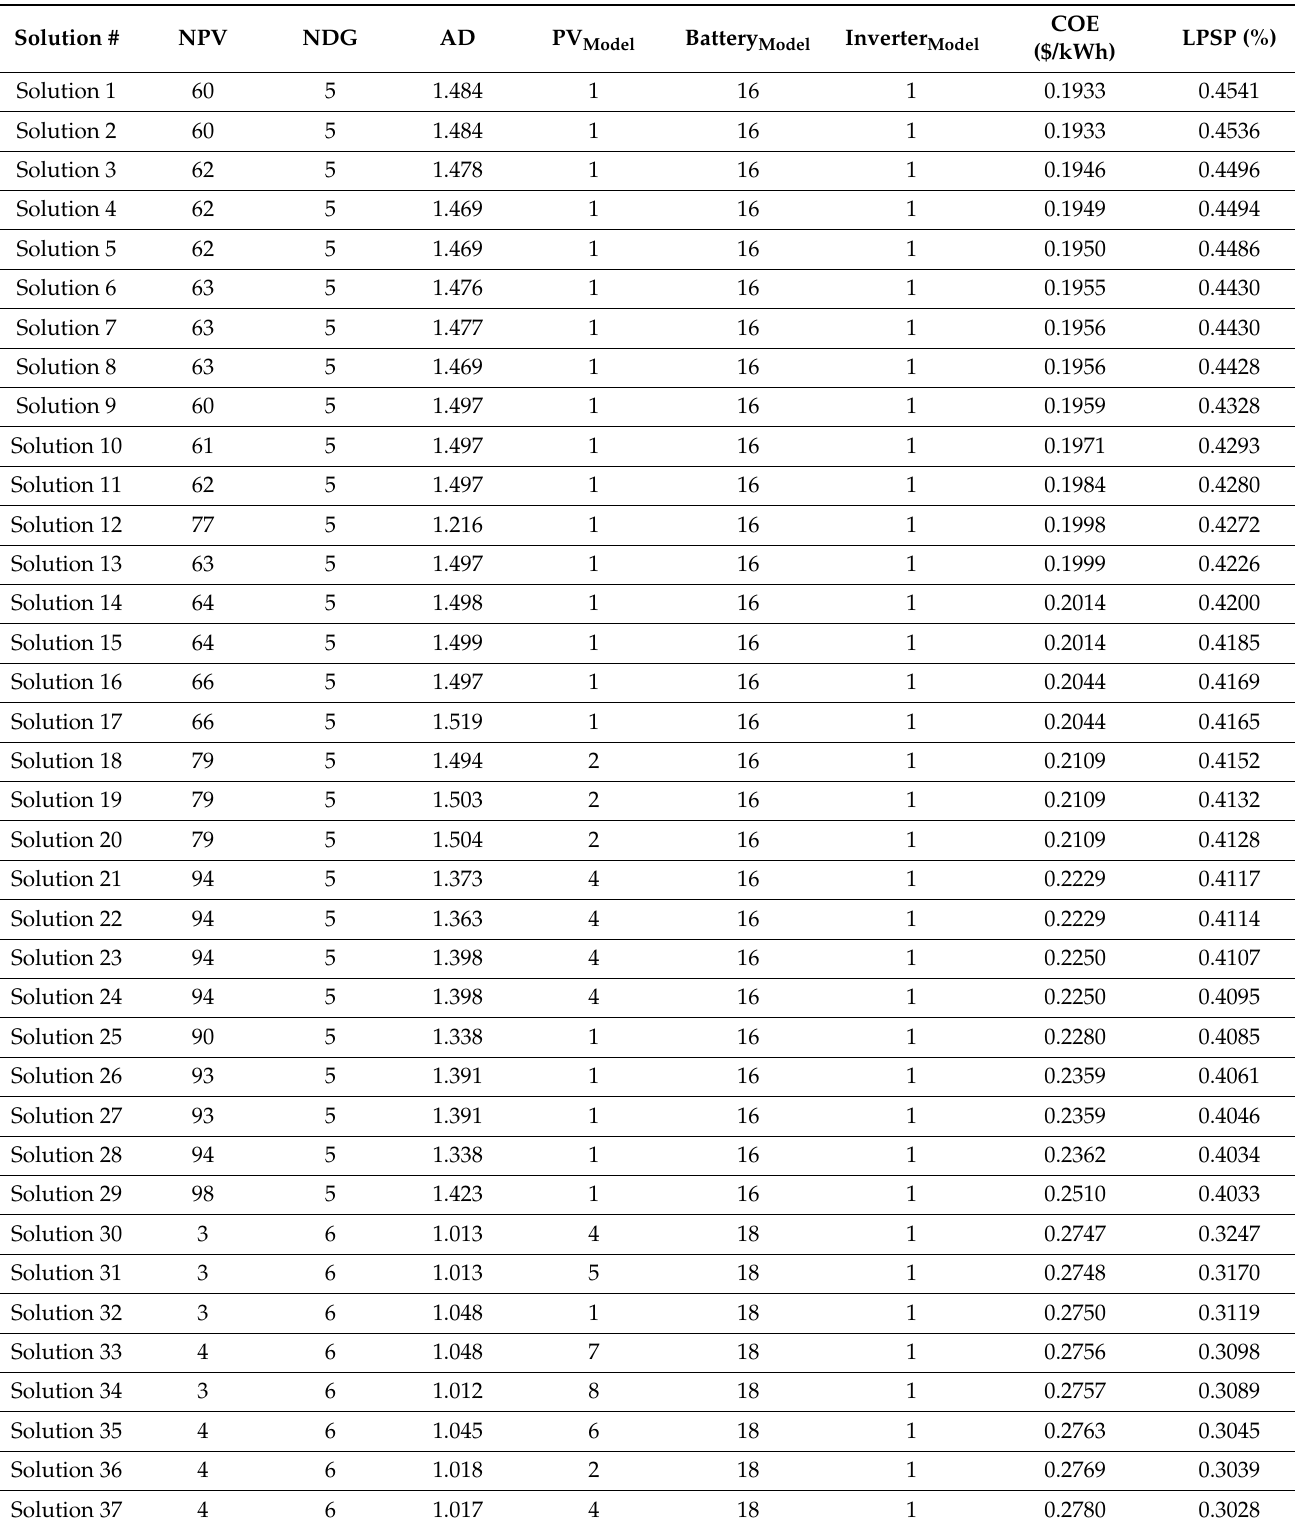
Table 3. Solutions from PF for CASE